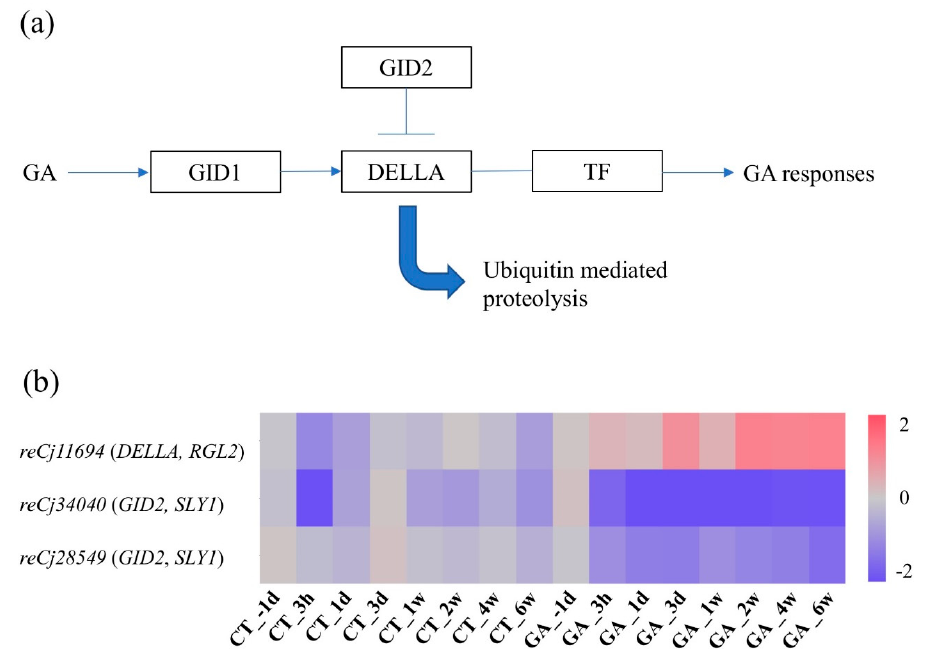
Figure 4. The DEG analysis associated with gibberellin (GA) signal transduction. ( a ) GA signal transduction pathway modified KEGG plant hormone signal transduction reference pathway (https://www.genome.jp/kegg-bin/show_pathway?map04075). GID1: GA INSENSITIVE DWARF 1, DELLA: DELLA protein, GID2: GIBBERELLIN INSENSITIVE DWARF 2, TF: transcription factor; ( b ) The heat-map of DEGs associated with GA signal transduction of each sample. The relative expression values were log 2 transformed. Red indicates high expression; blue indicates low expression. CT_ − 1 d, CT_3 h, CT_1 d, CT_3 d, CT_1 w, CT_2 w, CT_4 w, CT_6 w, GA_ − 1 d, GA_3 h, GA_1 d, GA_3 d, GA_1 w, GA_2 w, GA_4 w, and GA_6 w are sample names. Details of these genes are provided in Table